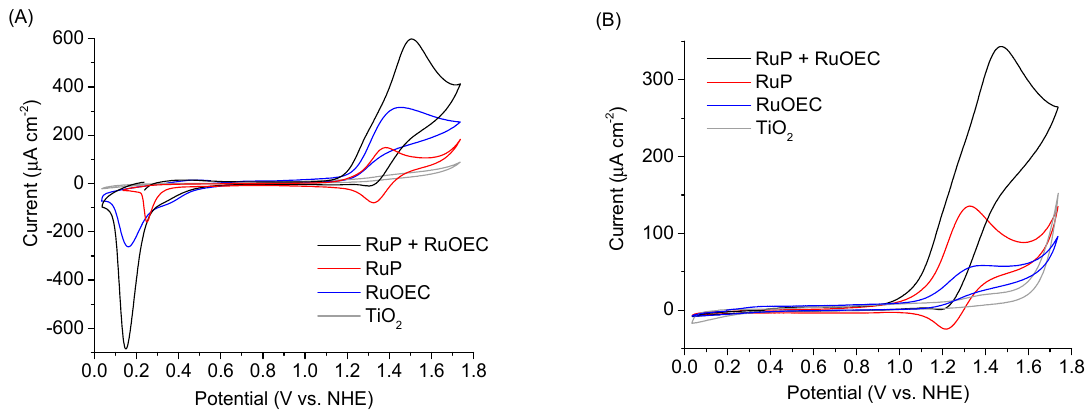
Figure 4. Cyclic voltammograms of TiO 2 photoanode pure and sensitized with RuP, RuOEC, or RuP + RuOEC in ( A ) HCl (pH ≈ 3) and ( B ) 0.07 M phosphate buffer solution (pH ≈ 7), recorded in the dark. NHE: Normal hydrogen electrode.